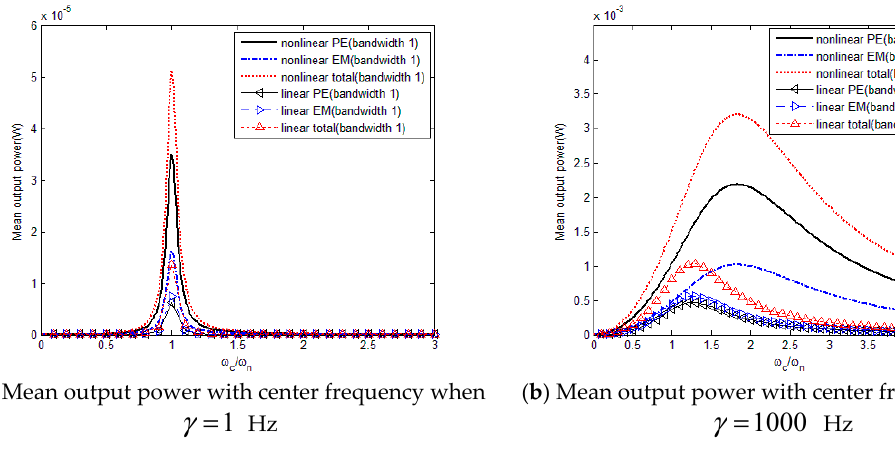
Figure 12. Mean output power of hybrid energy harvester with center frequency under different Mean output power of hybrid energy harvester with center frequency under bandwidths. different